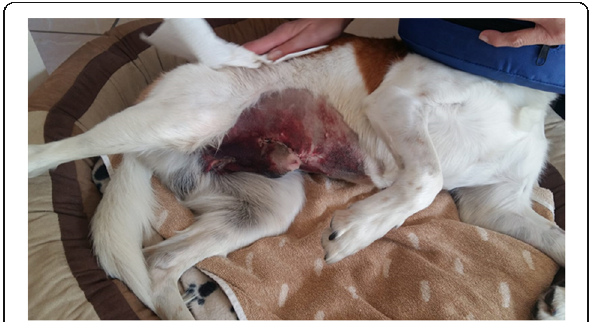
Fig. 6 Kromfohrländer with excessive hematomas. This picture shows a male Kromfohrländer three days after neutering and surgical excision of cystine crystals and calculi due to cystinuria with massive hematomas. The dog is heterozygous (WT/MUT) for the von Willebrand type 1 mutation. The vWF serum level was determined with a value of